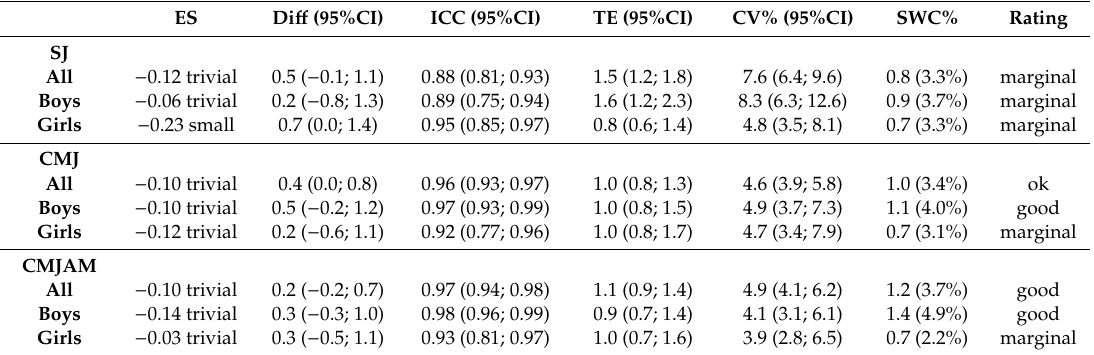
Table 2. Reliability measure for My Jump 2 in primary school